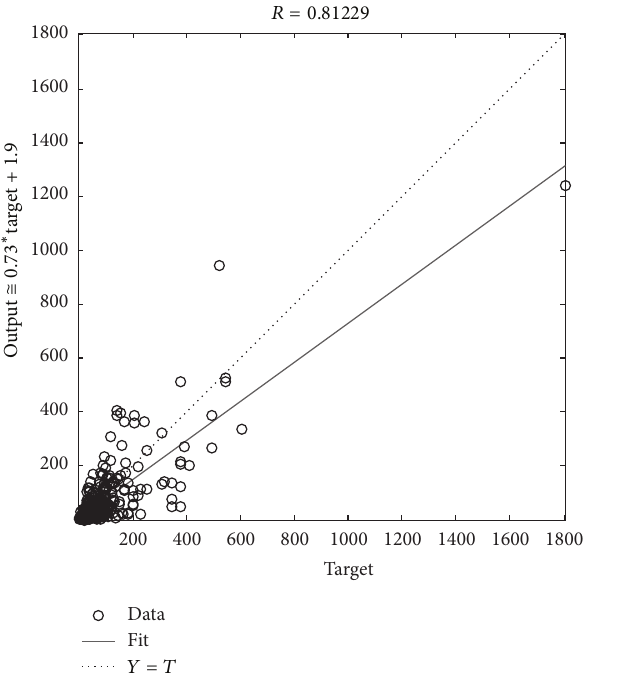
Figure 12: GA steel expression. Figure 13: GA zinc